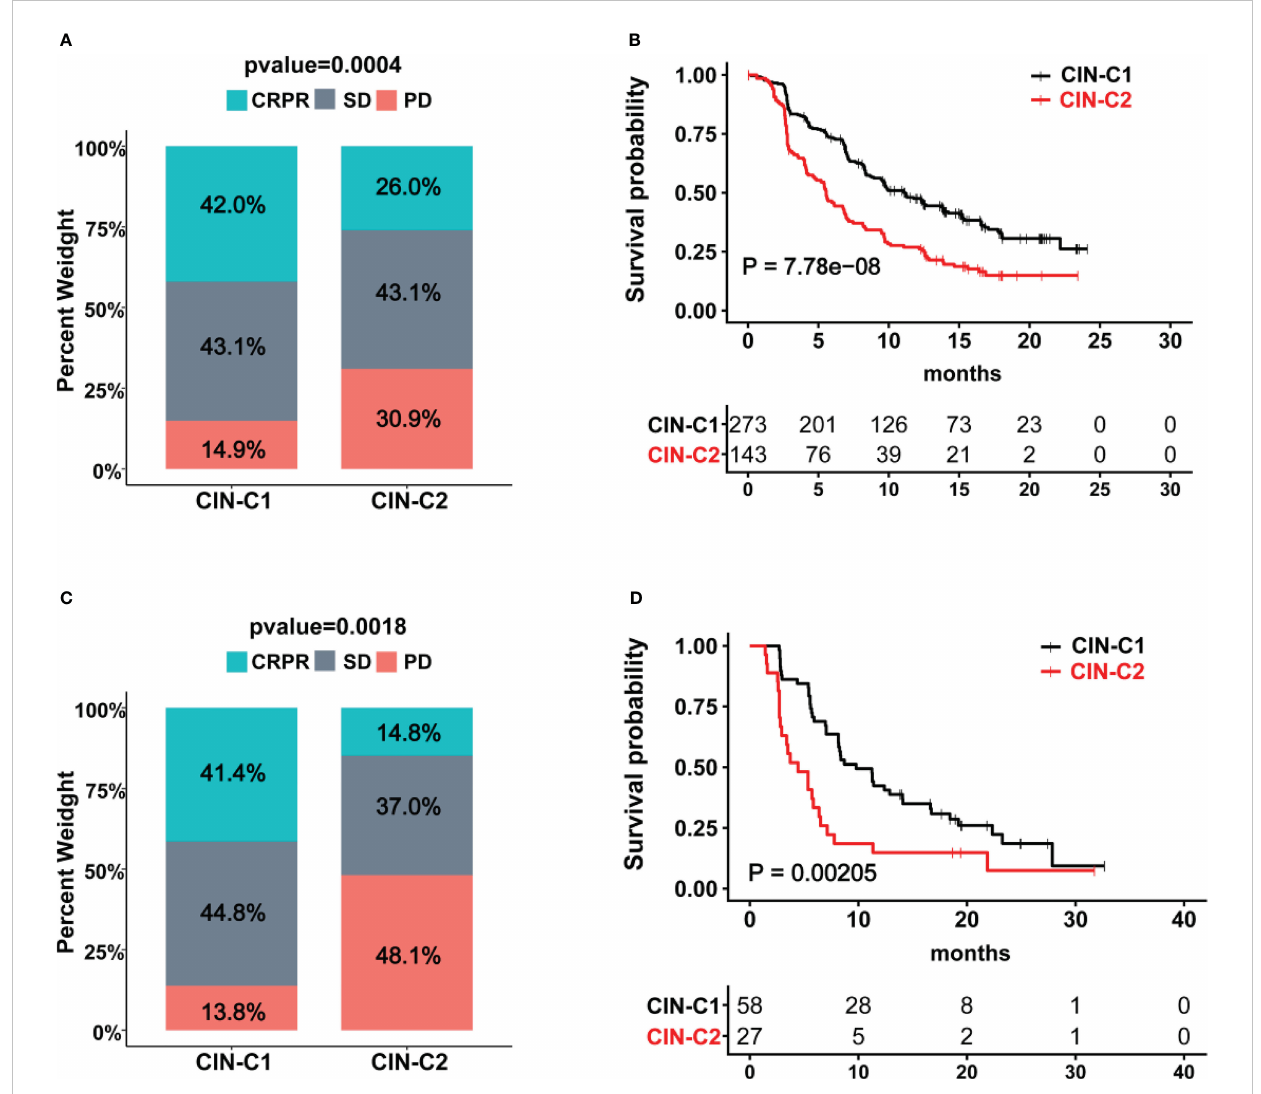
FIGURE 6 The CIN25 subtypes for prediction of Sunitinib response in ccRCCs. (A, B) IMmotion151 cohort of ccRCC patients treated with Sunitinib. Poor response to Sunitinib and shorter patient PFS in the CIN25-C2 group. (C, D) IMmotion150 cohort of ccRCC patients treated with Sunitinib. Poor response to Sunitinib and shorter patient PFS in the CIN25-C2